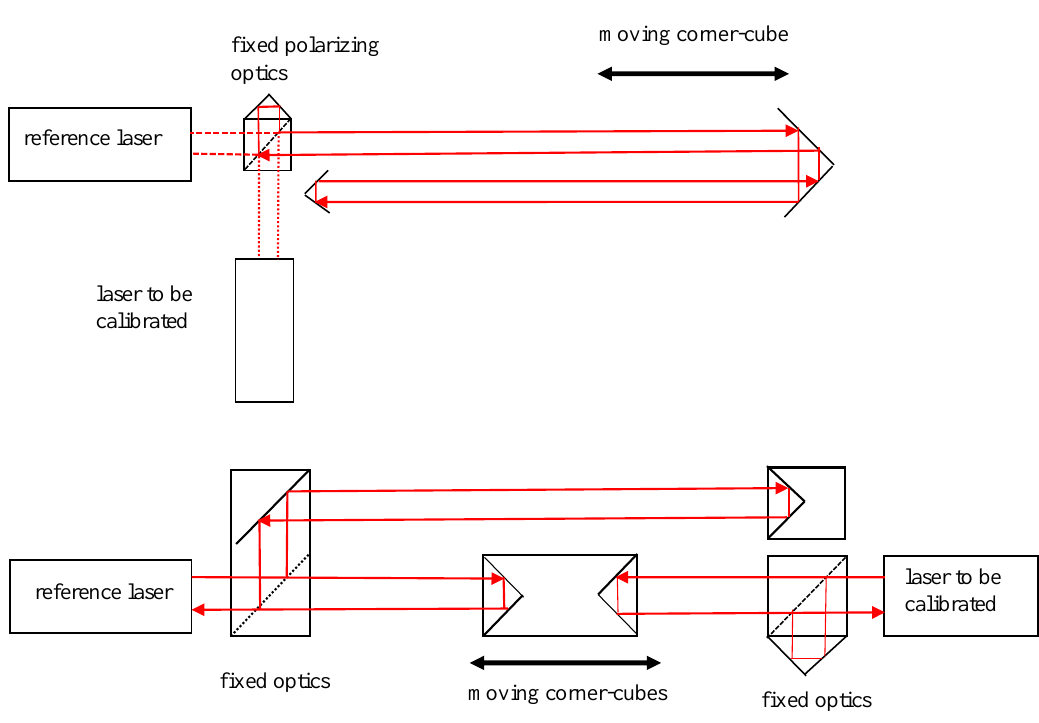
Figure 4. Two configurations for a comparison configuration. Top: with folded beam and joint light path and optics; bottom: compensated back-to-back